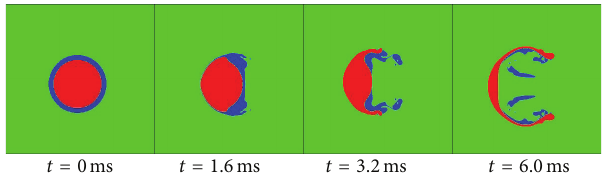
Figure 15: Evolution of a droplet with a vapor film (film thickness: 0.5 mm).